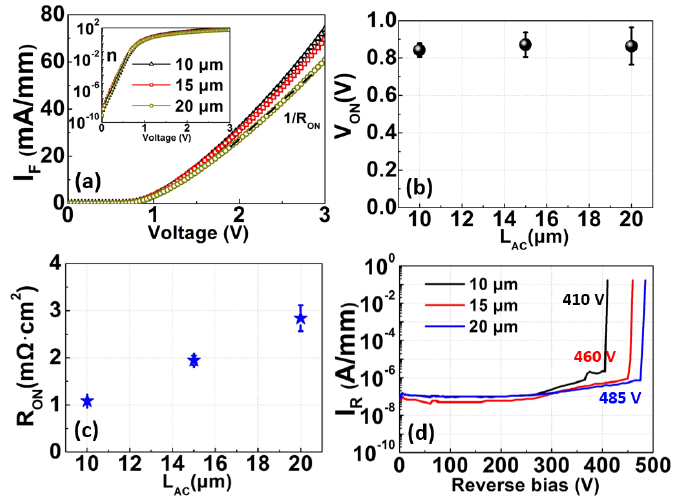
Figure 5. ( a ) the forward characteristics of the SBDs (with four rows of circular anode trenches) with di ff erent L AC ; ( b ) the V ON of SBDs (with four rows of circular anode trenches) with di ff erent L AC ; ( c ) the R ON of the SBDs (with four rows of circular anode trenches) with di ff erent L AC ; ( d ) the reverse-bias log scale (absolute values) two-pole characteristics for the SBDs (with four rows of circular anode trenches) with di ff erent L AC